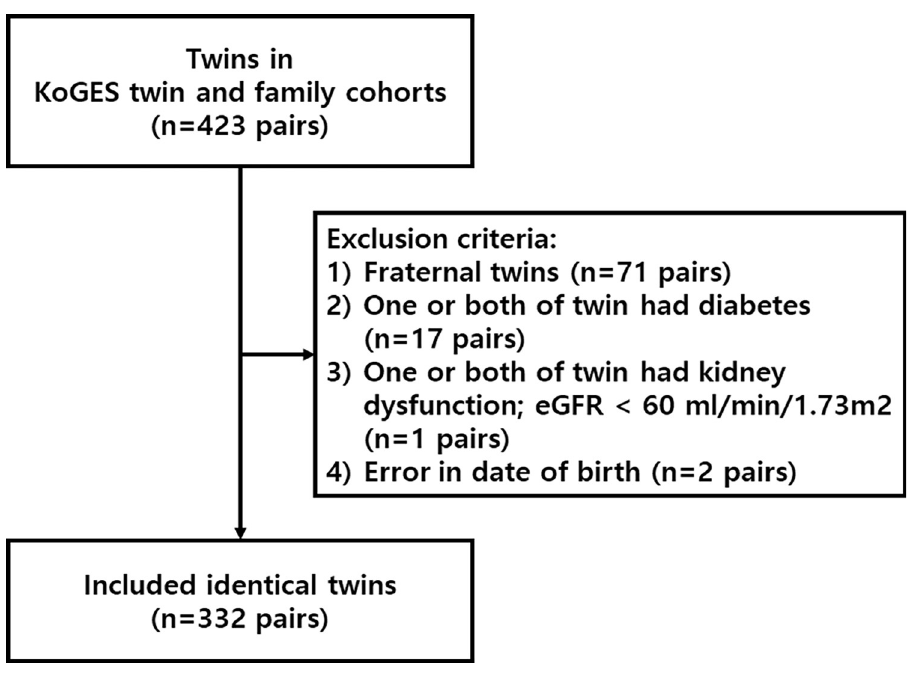
Fig 1. Flow diagram for participant